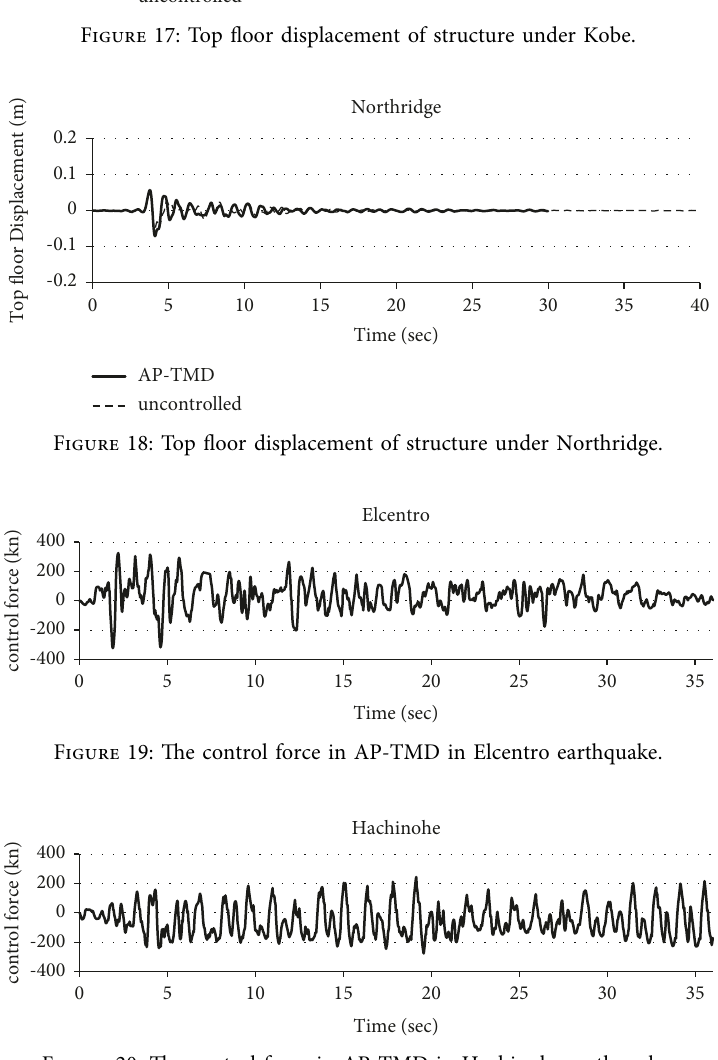
Figure 20: The control force in AP-TMD in Hachinohe earthquake.